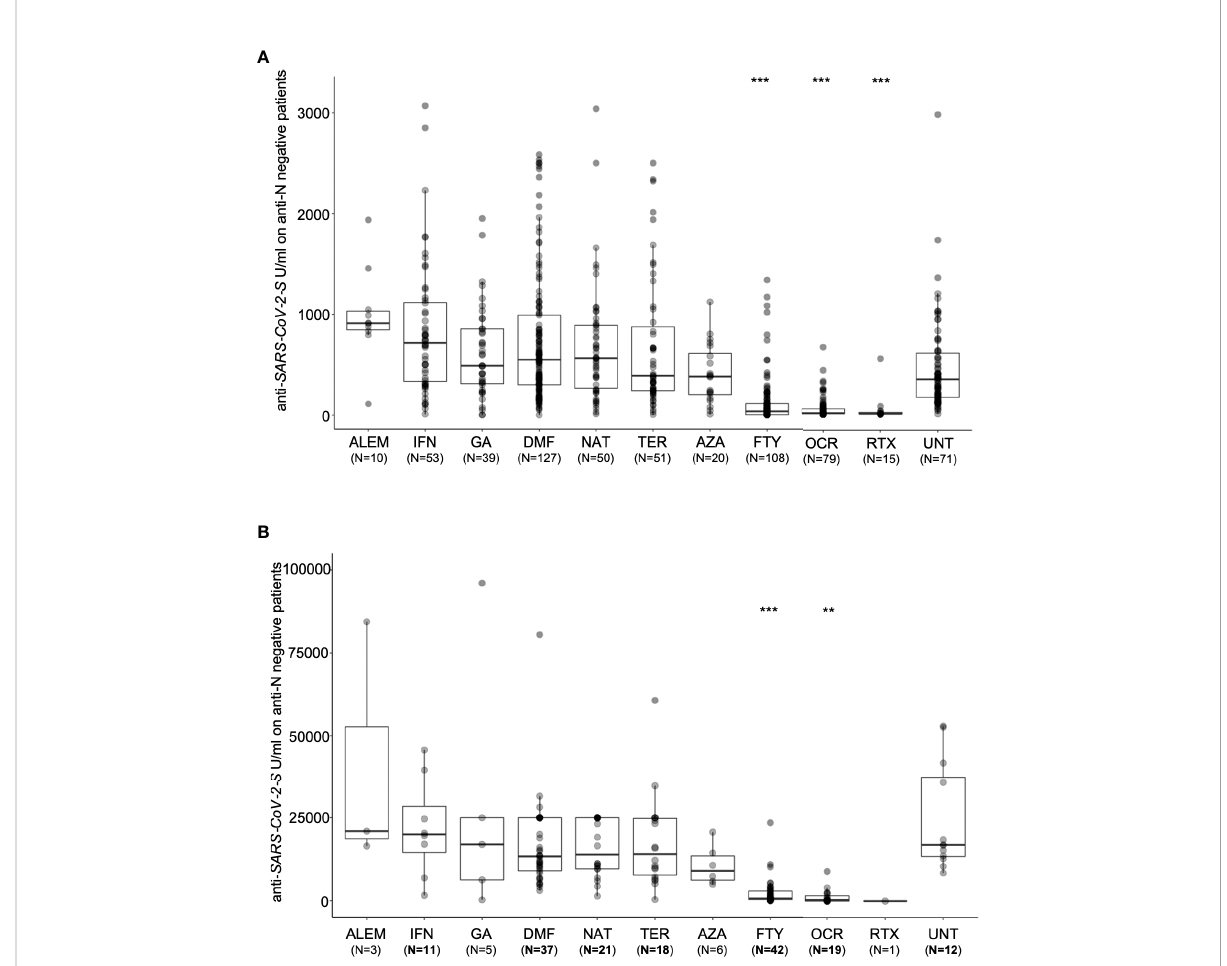
FIGURE 2 Post-vaccination SARS-CoV-2 anti-S antibody response by disease- modifying therapy (DMT) in MS patients negative for anti-N antibodies. (A) Antibody response to SARS-CoV-2 vaccination by DMT in MS patients six month after SARS-CoV-2 vaccination (T2). (B) Antibody response one month after booster (T3) by DMT in MS patients. Results are reported as boxplots, showing the median value (in bold) and the quartiles as box limits; whiskers at the top and bottom sides represent the overall maximum value and the overall minimum value, respectively. Data outside boxes and whiskers represent the outliers of the distribution. (**P<0.01; ***<0.001). (UNT, untreated; ALEM, alemtuzumab; IFN, interferon; GA, glatiramer acetate; DMF, dimethyl fumarate; NAT, natalizumab; CLA, cladribine; TER,teri fl uomide; AZA, azathioprine; FTY, fi ngolimod; RTX, rituximab; OCR,